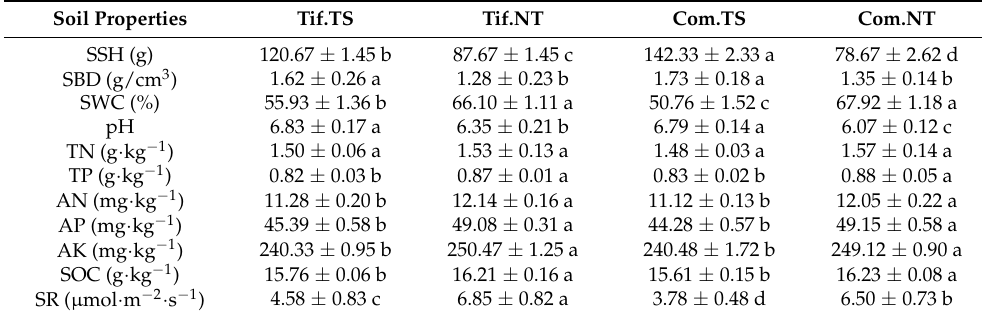
Table 1. Soil physicochemical properties under traffic